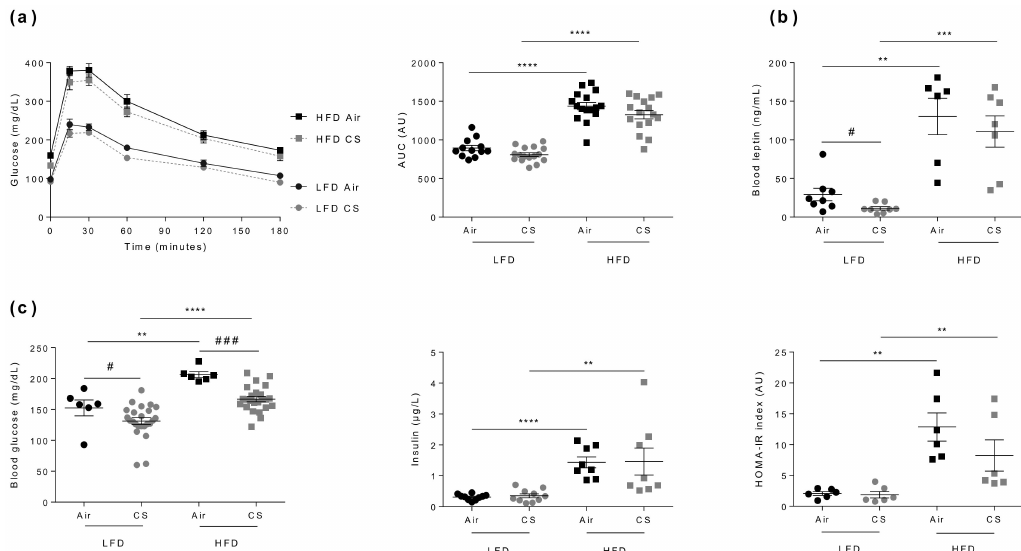
Figure 2. Chronic cigarette smoke (CS) exposure has no impact on glucose homeostasis in lean (LFD) and obese (HFD) mice. (a) IP-GTT was performed at week-24. Blood glucose levels (expressed in mg / dL) were measured in overnight-fasted mice (0) and at the indicated times following glucose administration (left panel). The corresponding AUC values are shown (expressed in AU) (right panel), n = 12–16 per group. (b) Fasted (7 hours fasting) blood leptin levels (expressed in ng / mL) were quantified at week-15 ( n = 6–8 mice per group). (c) Fasted (7 hours fasting) blood glucose (expressed in mg / dL) (left panel) and insulin (expressed in µ g / L) (middle panel) levels were evaluated at week-15, and the homeostatic model for assessment of insulin resistance (HOMA-IR) was calculated (right panel), n = 6 mice per group. Data are expressed as individual and mean ± SEM. values. ** p < 0.01, *** p < 0.001, **** p < 0.0001, * correspond to diet e ff ect (HFD vs. LFD), and # p < 0.05, ### p < 0.001, #correspond to CS e ff ect (CS vs.